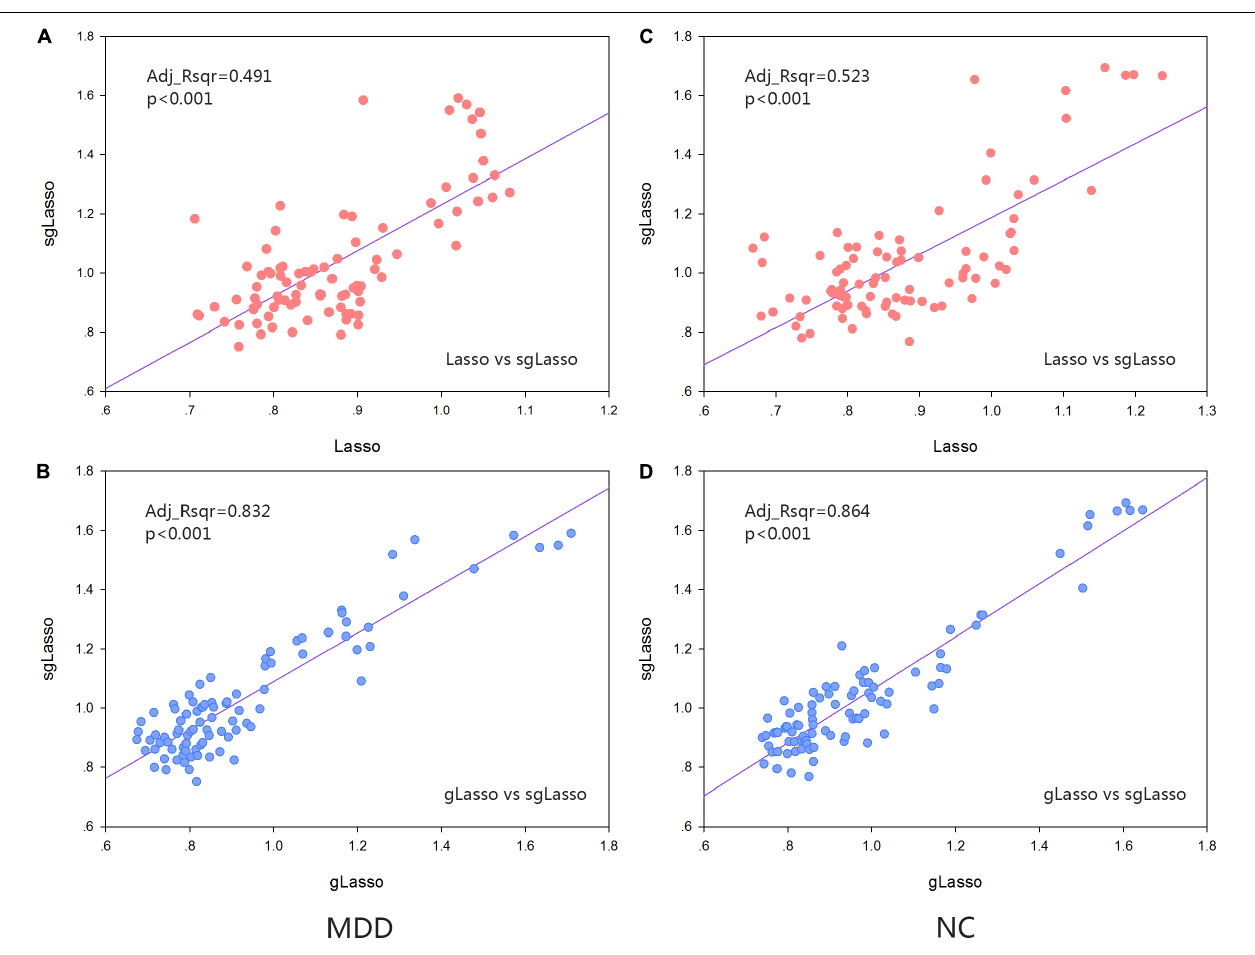
FIGURE 6 | Regression analysis about the standardized metric values about the COMHCC metrics. (A) Regression analysis from that obtained by sparse group lasso and lasso method in the MDD group. (B) Regression analysis from that obtained by sparse group lasso and group lasso method in the MDD group. (C) Regression analysis from that obtained by sparse group lasso and lasso method in the NC group. (D) Regression analysis from that obtained by sparse group lasso and group lasso method in the NC group.